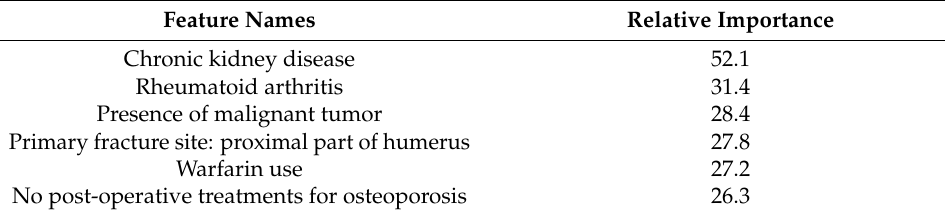
Table 3. Relative importance of the top six features among the categorical variables.